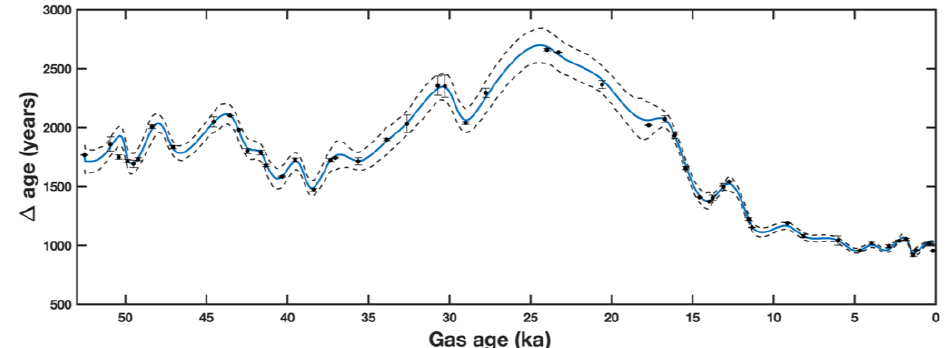
Figure 3. Empirically derived (cid:49) age history for the SPC14 ice core, derived as described in the text. Blue line is a spline fit to the (cid:49) age points. (cid:49) age error bounds (2 σ ), dashed lines, reflect uncertainties with (cid:49) age based on WD (cid:49) age uncertainty and relative SP19 uncertainties; black dots indicate individual (cid:49) age constraints (see